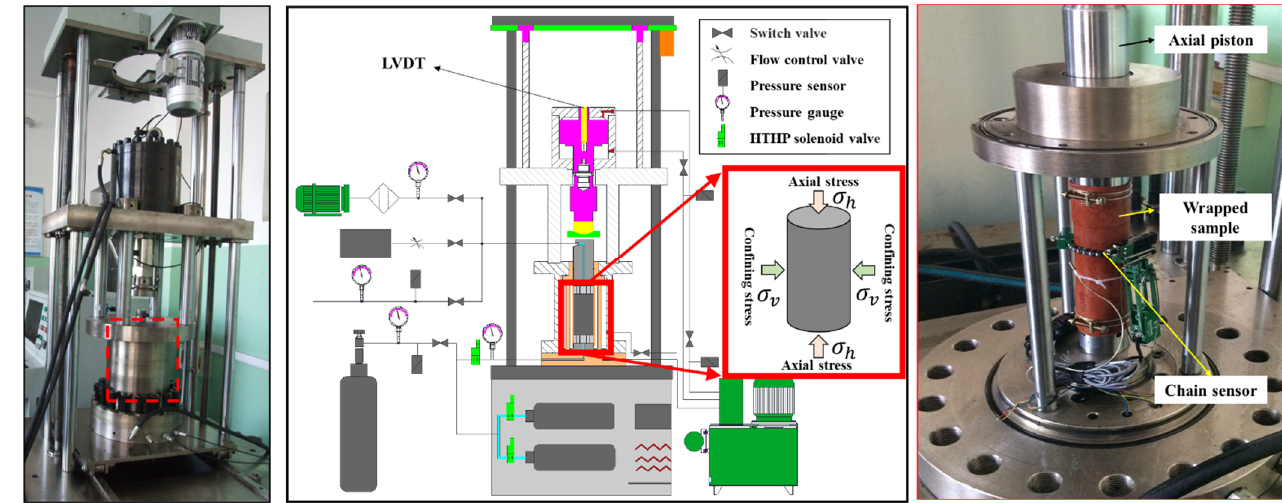
Figure 5. Picture and structure diagram of the WYS-800 test apparatus.